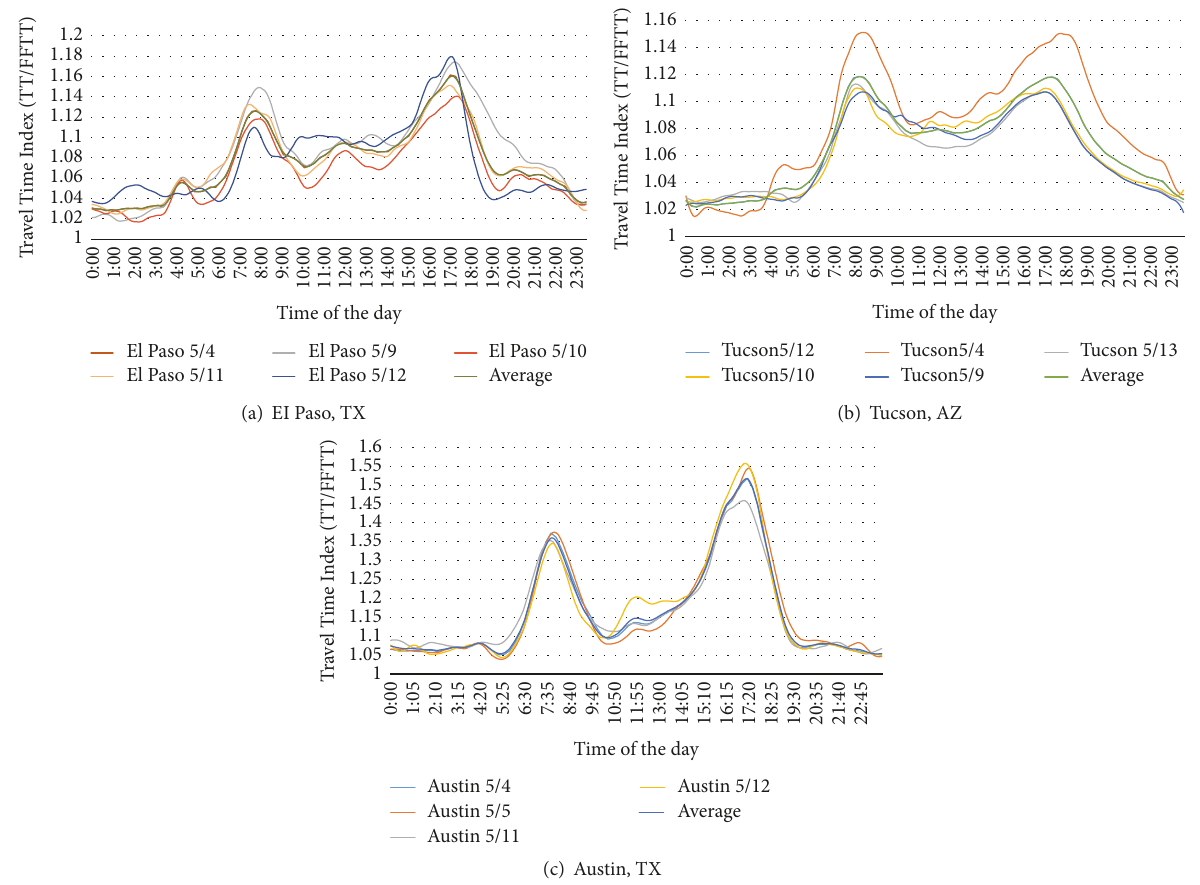
Figure 4: Temporal and network heterogeneity of traffic